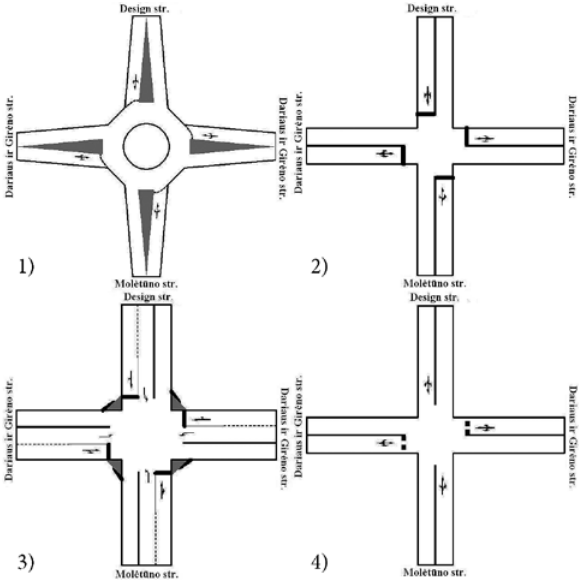
Fig. 5. Principal schemes of the intersections: 1 –